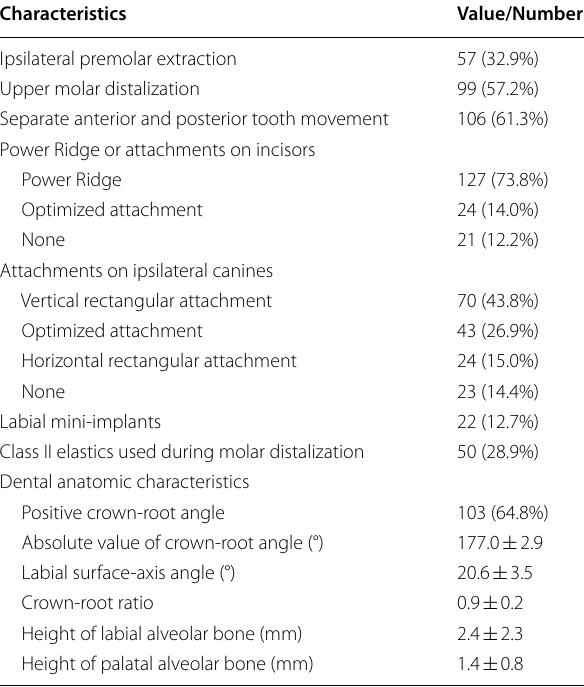
Table 2 Characteristics of study upper incisors